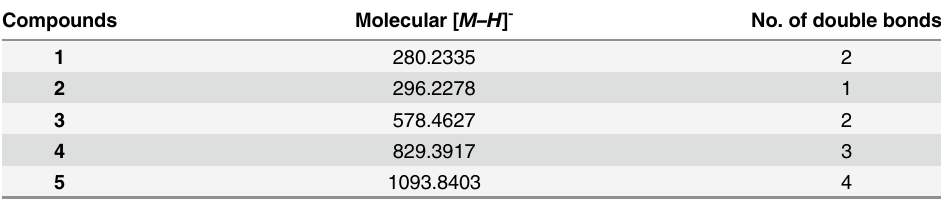
Table 3. LC-MS for the synthetic compounds and data used for their